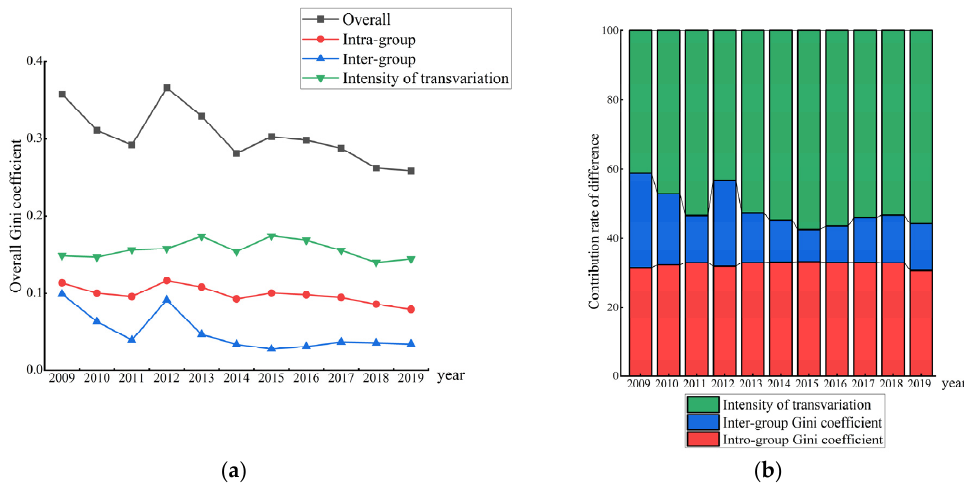
Figure 5. Spatial differentiation ( a ) and contribution rate ( b ) of EWP in the YREB.